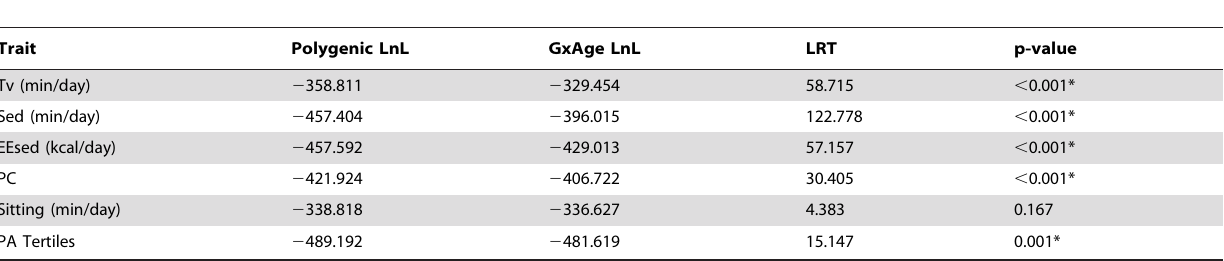
Table 4. Results of log-likelihood ratio tests (LRT) and respective p-values contrasting a polygenic model vs a GxAge model for each of the SB